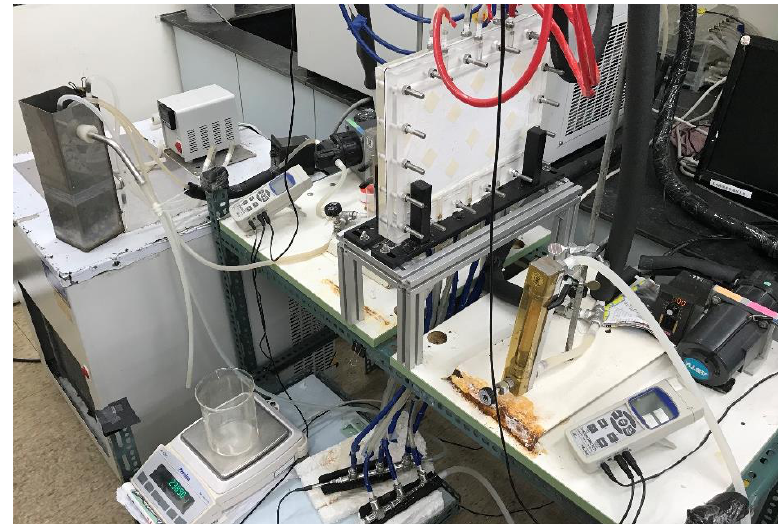
Figure 3. A photo of the experimental setup.